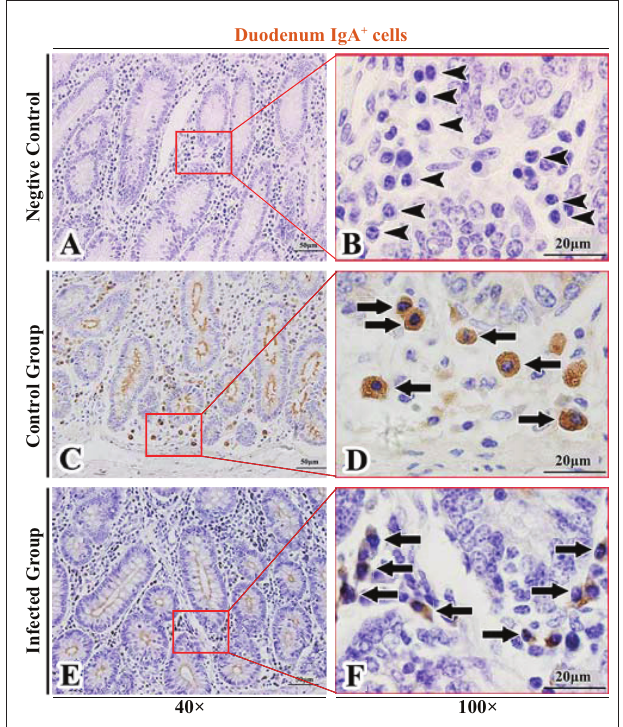
FIGURE 2 | Distribution of IgA + cells in sheep duodenum. (A,B) are negative controls; (C,D) are Control groups; (E,F) are Infected groups. Triangular arrows indicated plasma cells, arrows indicated IgA + cells, and the right image (Scale bar, 20 µ m) is a magnification from the part of the left image (Scale bar, 50 µ